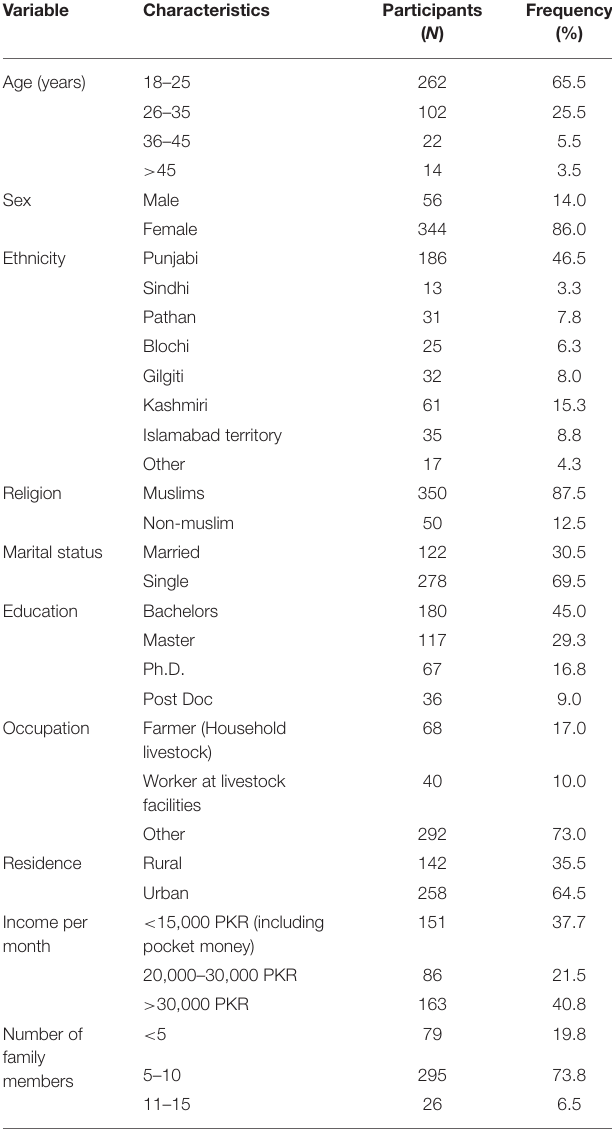
TABLE 1 | Socio-demographic characteristics of